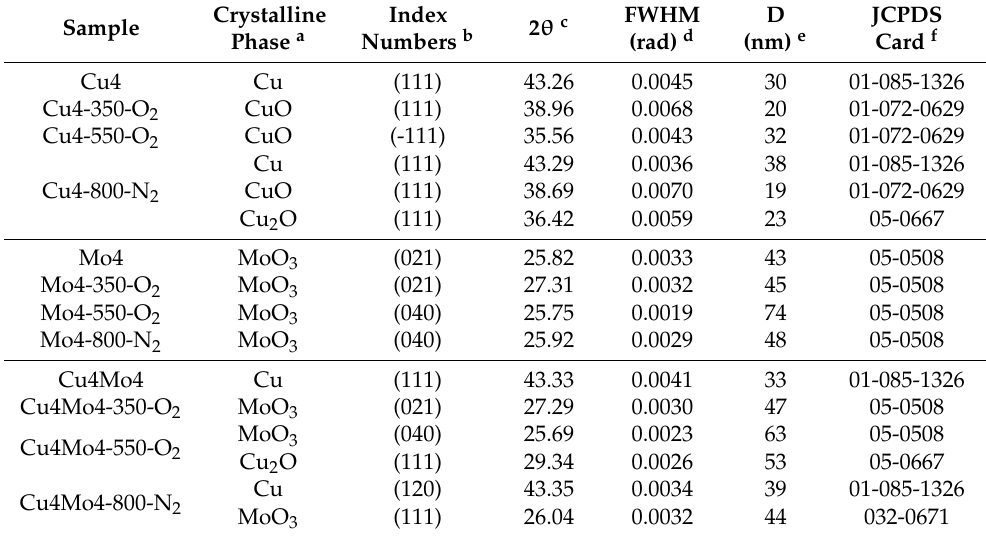
Table 3. Summary of the main crystalline parameters obtained from XRD.